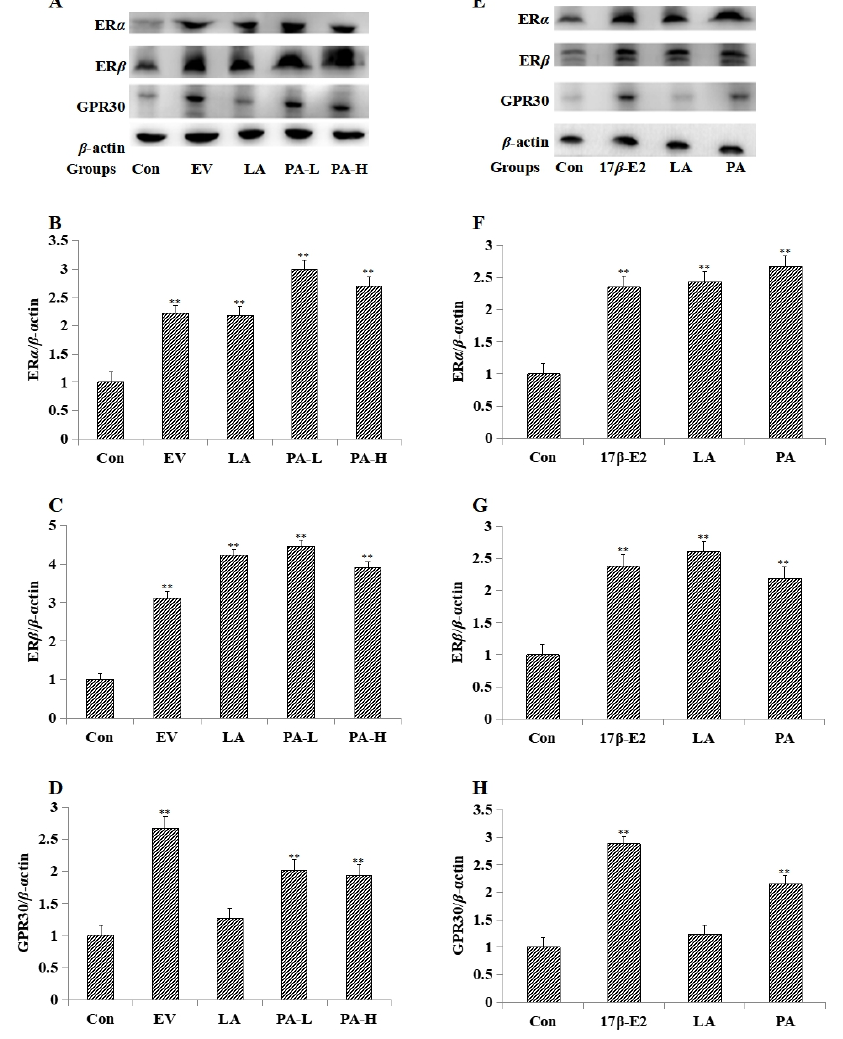
Figure 5. Western blot analysis of the expression of estrogen receptors in the uterus of immature female Swiss mice and MCF-7 cells ( n = 3). Figure ( A ), ( B ), ( C ) and ( D ) show the expression of ER α , ER β and GPR30 in the uterus. Figure ( E ), ( F ), ( G ) and ( H ) show the expression of ER α , ER β and GPR30 in MCF-7 cells. * p < 0.05; ** p < 0.01 compared to